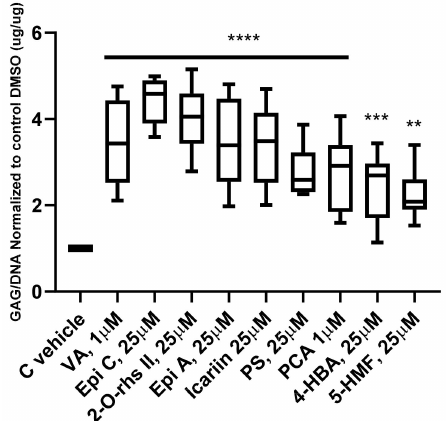
Figure 1. Glycosaminoglycan (GAG) production of 3D human osteoarthritic chondrocyte pellet cultures after two weeks in chondro-permissive medium supplemented with Traditional Chinese Medicine (TCM) compounds. Glycosaminoglycan content was normalized to the amount of DNA. The most e ff ective doses of compounds which could promote GAG production versus control vehicle (C vehicle) group in 3 / 3 donors are shown; for each donor three experimental replicates were analyzed. For statistical analysis using Graphpad Prism, one-way analysis of variance (ANOVA) followed by Dunnett’s post hoc test (multiple comparison) was applied. ** p < 0.001, *** p < 0.0005, **** p < 0.0001 versus control vehicle. Vanilic acid (VA), Epimedin A (Epi A) and C (Epi C), 2 (cid:48)(cid:48) -O-rhamnosylicariside II (2-O-rhs II), Icariin, Psoralidin (PS), Protocatechuicaldehyde (PCA), 4-Hydroxybenzoic acid (4-HBA), 5-Hydroxymethylfurfural